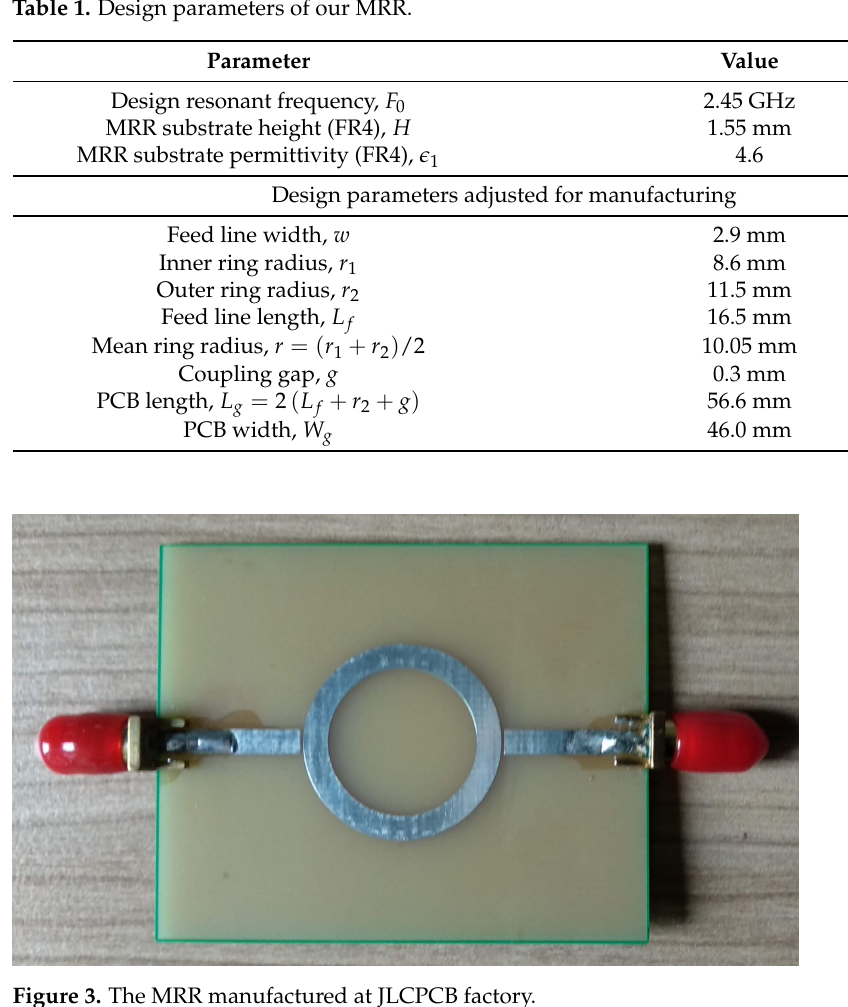
Figure 3. The MRR manufactured at JLCPCB